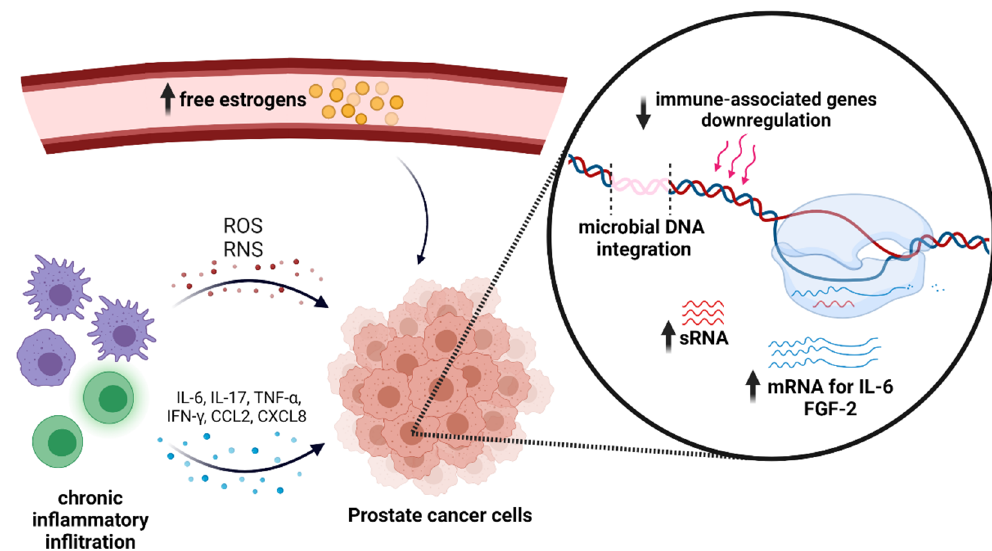
Figure 1. Microbial impact on prostate cancer. Created with BioRender.com (access on 10 July 2021). ROS—reactive oxygen species; RNS—reactive nitrogen species. Table 1. Selected microbial factors and its role in prostate cancer development.